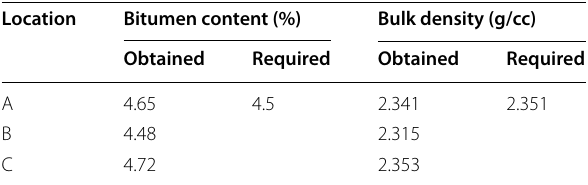
Table 6 Bitumen and bulk density of field-collected samples from different locations Location Bitumen content (%) Bulk density (g/cc) Obtained Required Obtained